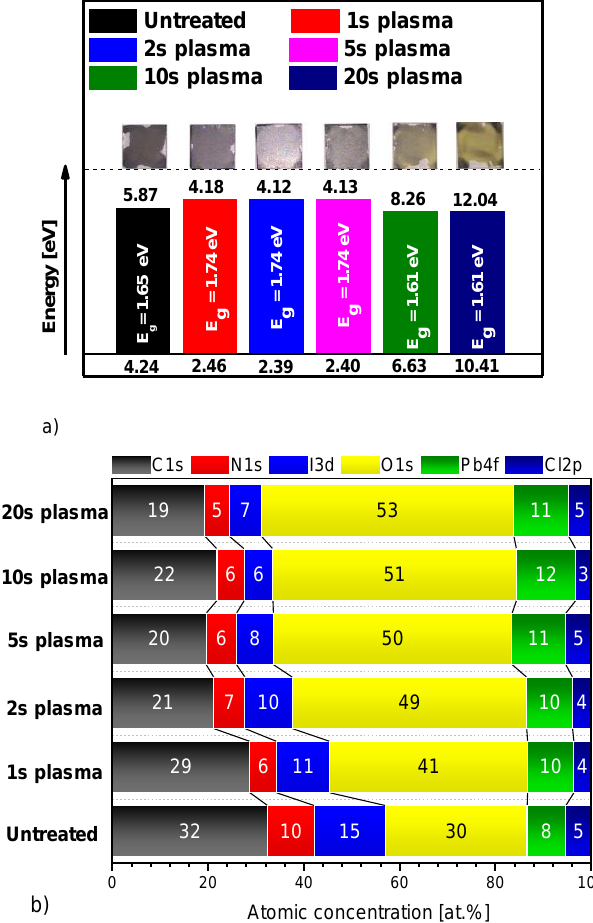
Figure 4. ( a ) Band energy diagram, with corresponding views from above of the mixed-halide perovskite film before and after plasma treatment. ( b ) Atomic concentration of elements in perovskite films calculated from XPS survey spectra.